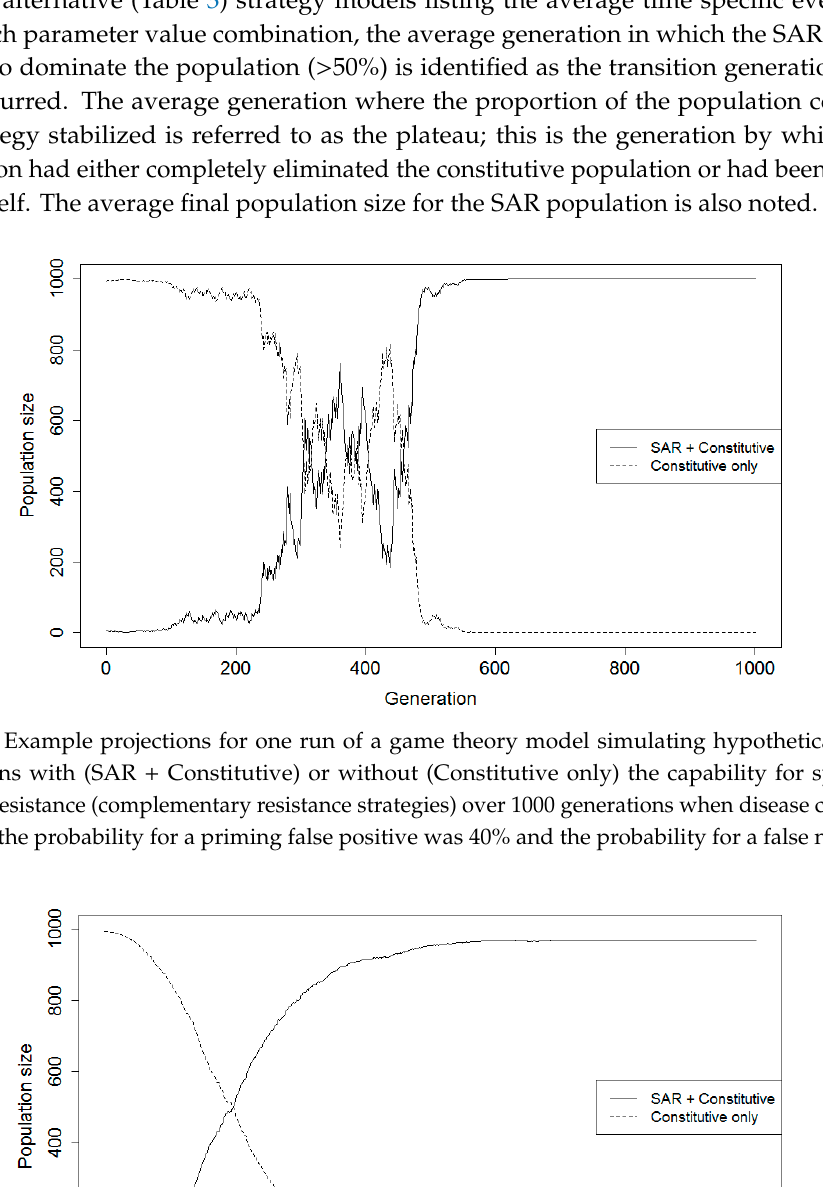
Figure 3. A summary of the various parameter value combinations was generated for complementary